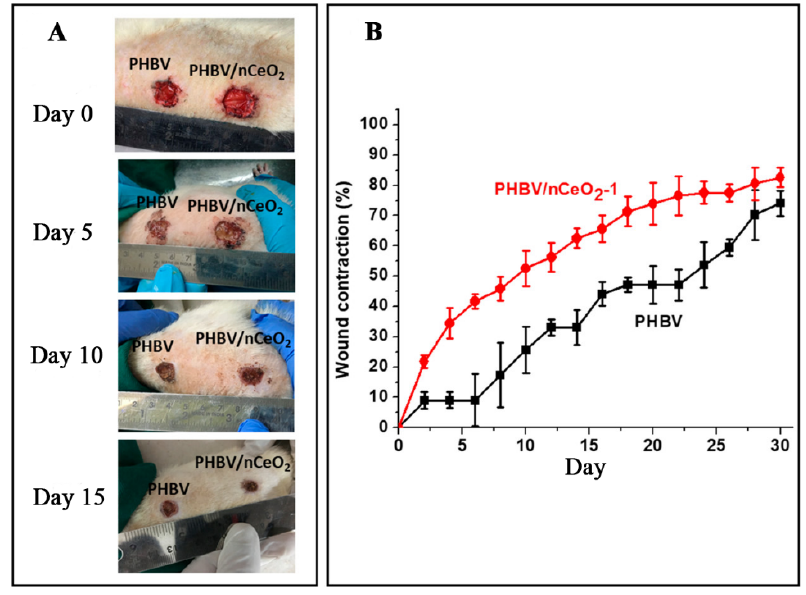
Figure 6. ( A ) Diabetic wound images, and ( B ) wound shrinkage curves treated with PHBV and PHBV/nCeO 2 -1 fibrous membranes. Reproduced with permission from [77] , ACS,